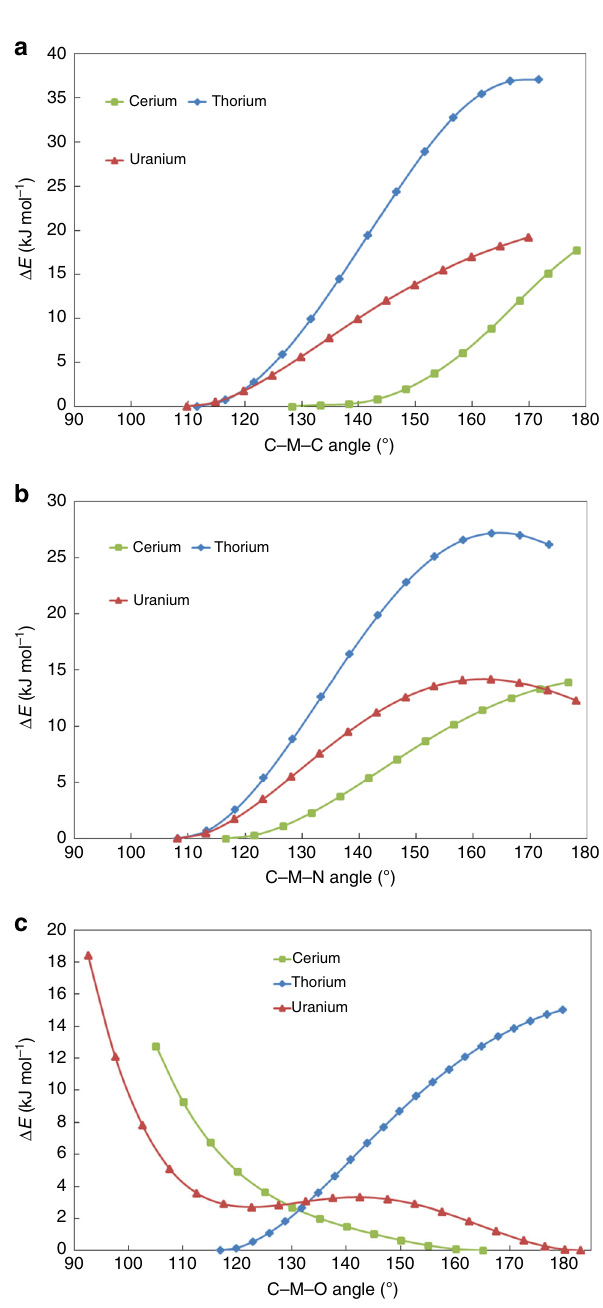
Fig. 4 PBE0 SCF energy surface scans of [C] = M = E angles, M = Ce, Th, U. a E = C(CH 3 ) 2 , b E = NCH 3 , c E = O. Energies (kJ mol − 1 ) are presented relative to those of the fully optimised structures